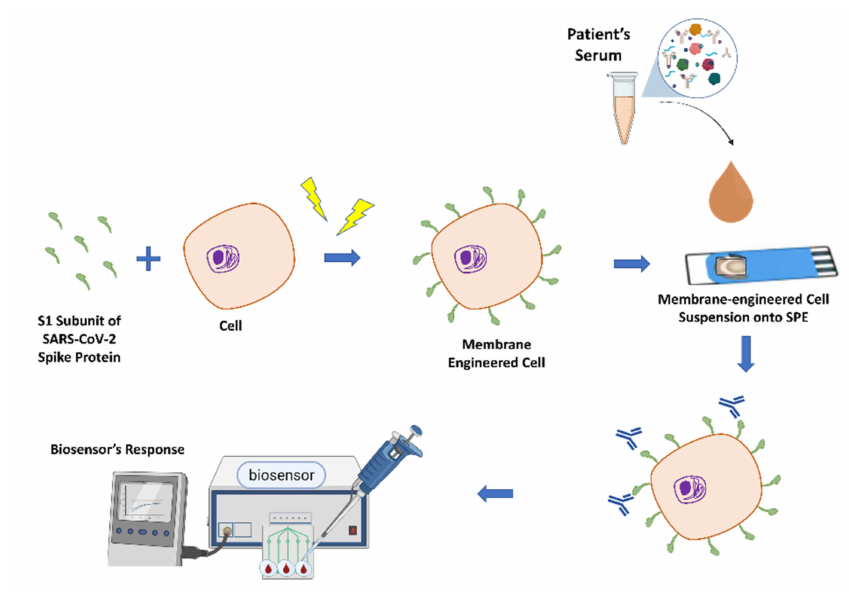
Figure 1. Membrane-engineered cells preparation and biosensor